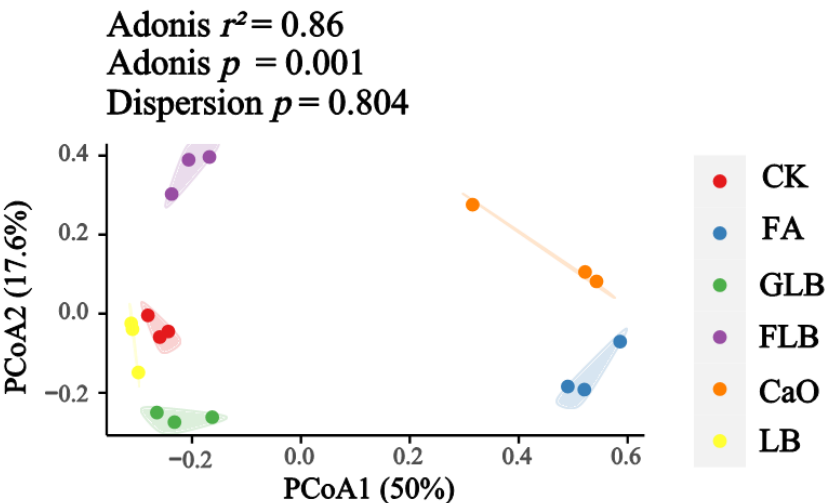
Figure 2. Principal coordinates analysis (PCoA) plot based on the Bray–Curtis dissimilarity matrix of the bacterial communities in alfalfa silages. Adonis: permutational Multivariate analysis of variance (MANOVA). CK, control, no additive; FA, 0.6% formic acid; CaO, 3% calcium oxide and 3% urea; LB, 1 × 10 6 cfu/g L. buchneri ; GLB, 2% glucose and 1 × 10 6 cfu/g L. buchneri ; FLB, 2% fucoidan and 1 × 10 6 cfu/g L. buchneri .